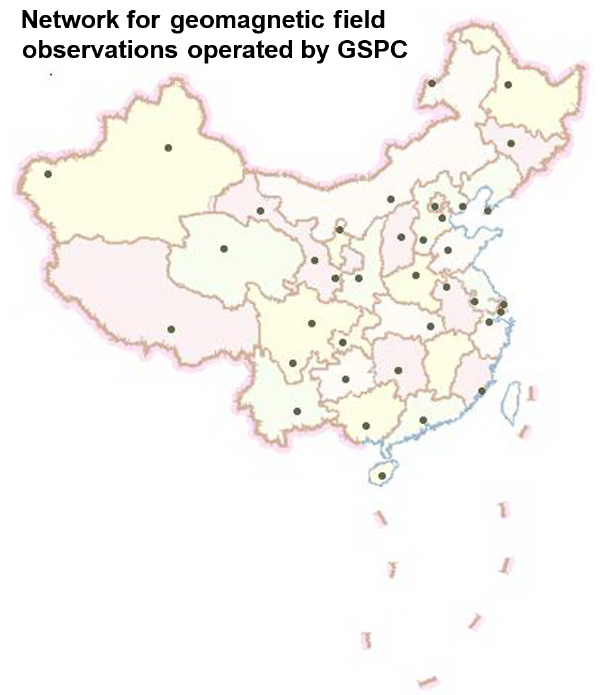
Figure 4. A map of the network for geomagnetic field observations operated by the GSPC.